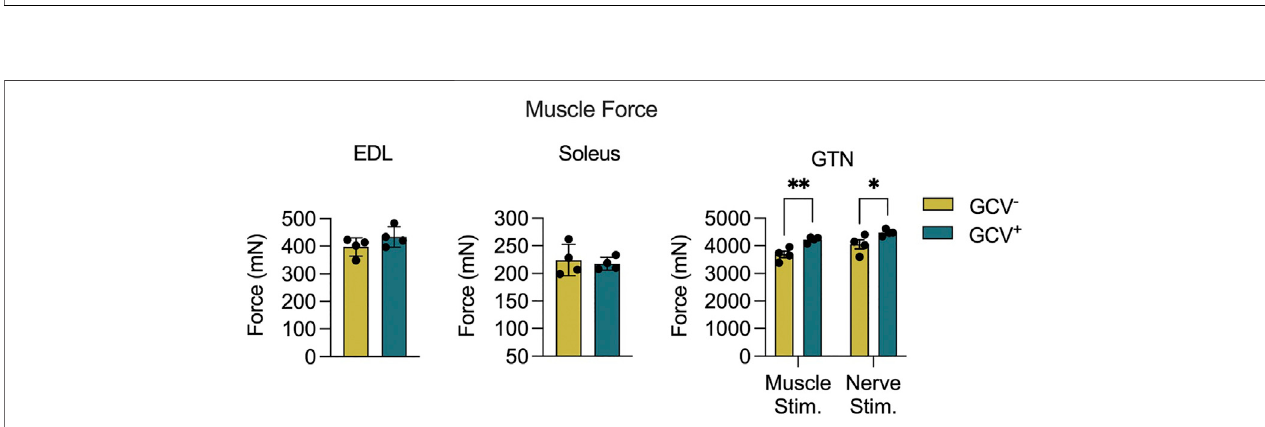
FIGURE3| Gastrocnemius(GTN)musclesfrommaleganciclovirtreated(GCV − )micegeneratedhigherforcesthanmusclesfromvehicletreated(GCV − )mice.Data are shown for maximum isometric tetanic force (P o ) generated by extensor digitorum longus (EDL), soleus and GTN muscles expressed in millinewtons (mN). EDL and soleusmuscleswereevaluated invitro ,whileGTNmuscleswereevaluated insitu usingbothdirectmusclestimulationandnervestimulation.Barsshowthemean±SEM of four mice per group with dots representing data from each individual male mouse. *Denotes p < .05 and ** denotes p < .01 between groups by two-tailed unpaired t-test.